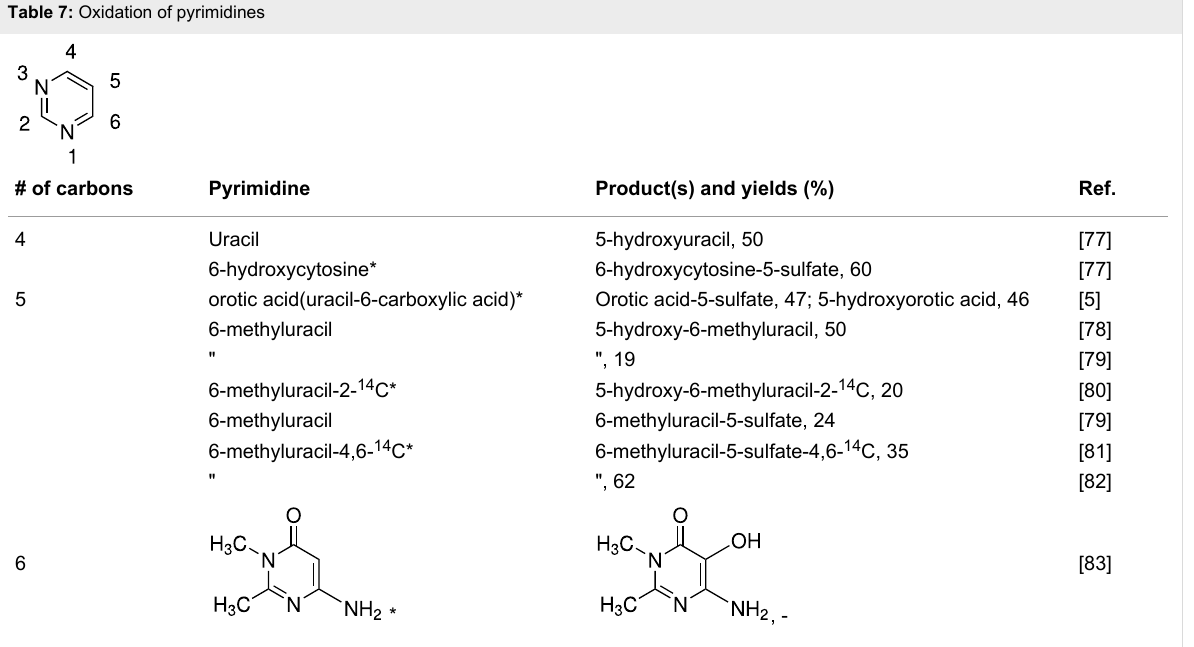
Table 7: Oxidation of pyrimidines